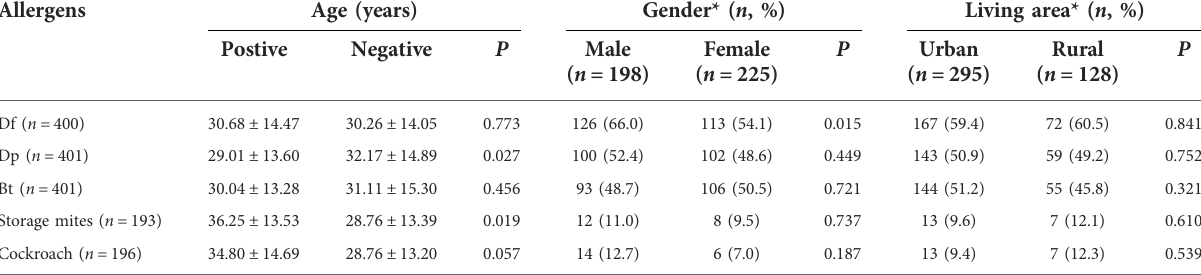
TABLE 2 Dermographic chracteristics of subjects with postive SPT, according to allergens.